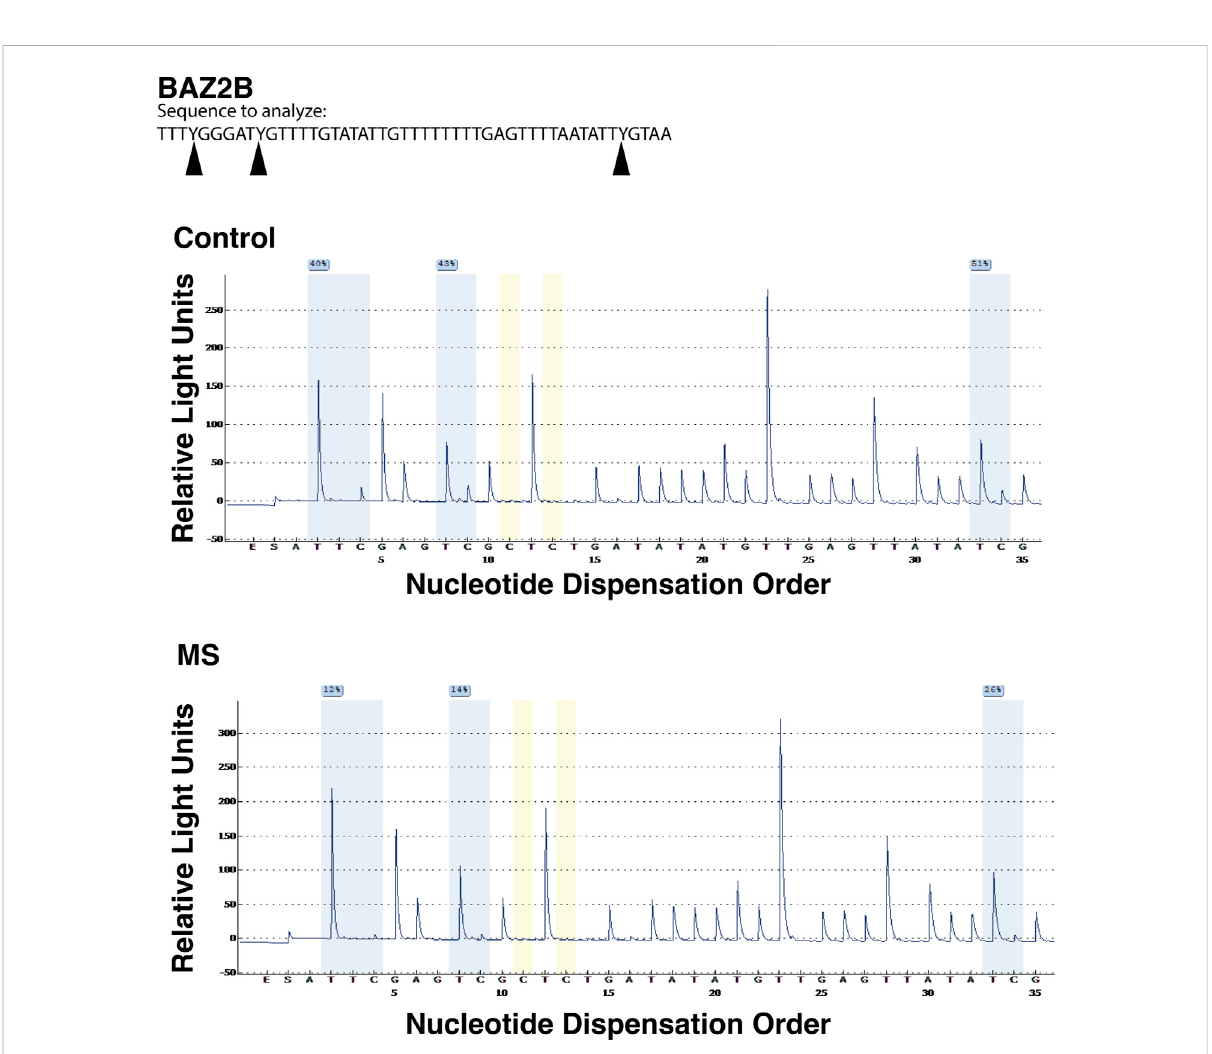
FIGURE 6 Pyrosequencinganalysis ofdifferentiallymethylated regions. Beadarraydata werecon fi rmedbypyrosequencingfollowingbisul fi teconversion of the differentially methylated region of interest. In this representative analysis, the region of interest is in the promoter region (TSS1500) of BAZ2B gene (sequence is at the top of the fi gure). CpG regions are highlighted in blue, the regions utilized for bisul fi te conversion controls are shown in yellow. For each of the 3 CpG regions analyzed, there was a relative reduction in the %methylation for the MS donor (bottom pyrogram) compared to the control